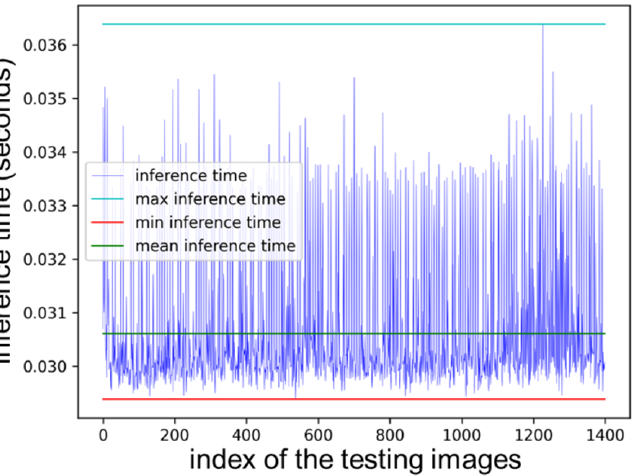
Figure A9. The inference time record. The max, min, and mean inference time is 0.0364, 0.0307, and 0.0294 s.